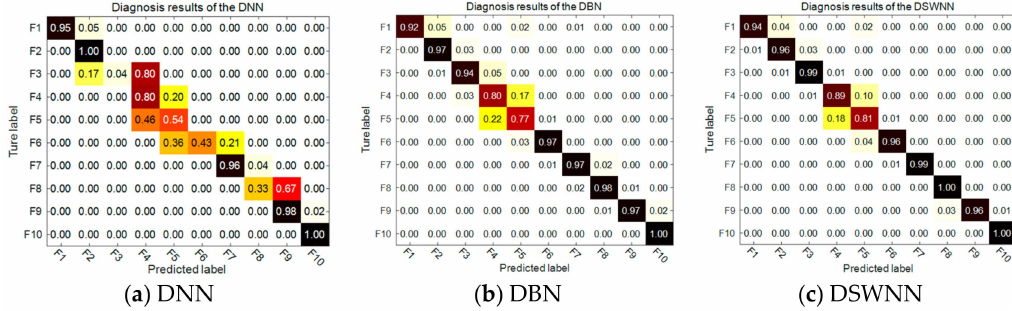
Figure 8. Comparison of three neural networks in classification accuracy of 10 types of